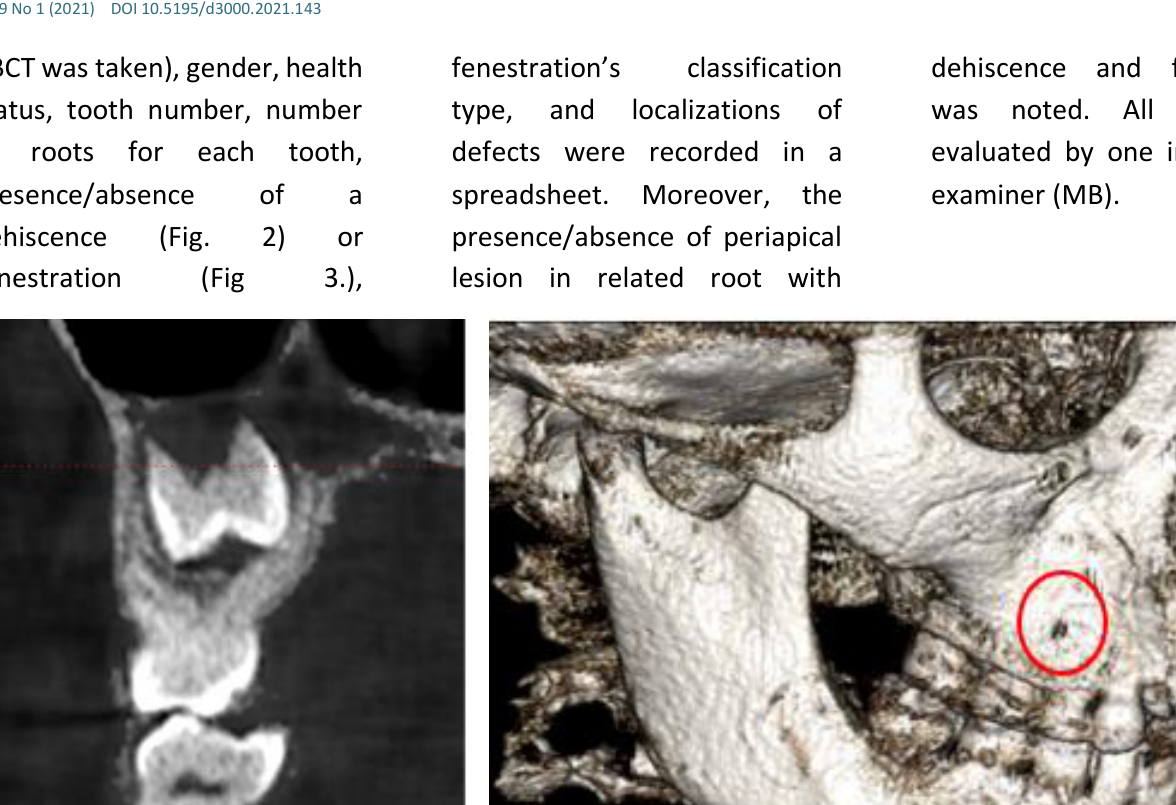
Figure 2. Presence of a dehiscence. Figure 3. Presence of fenestration - Type